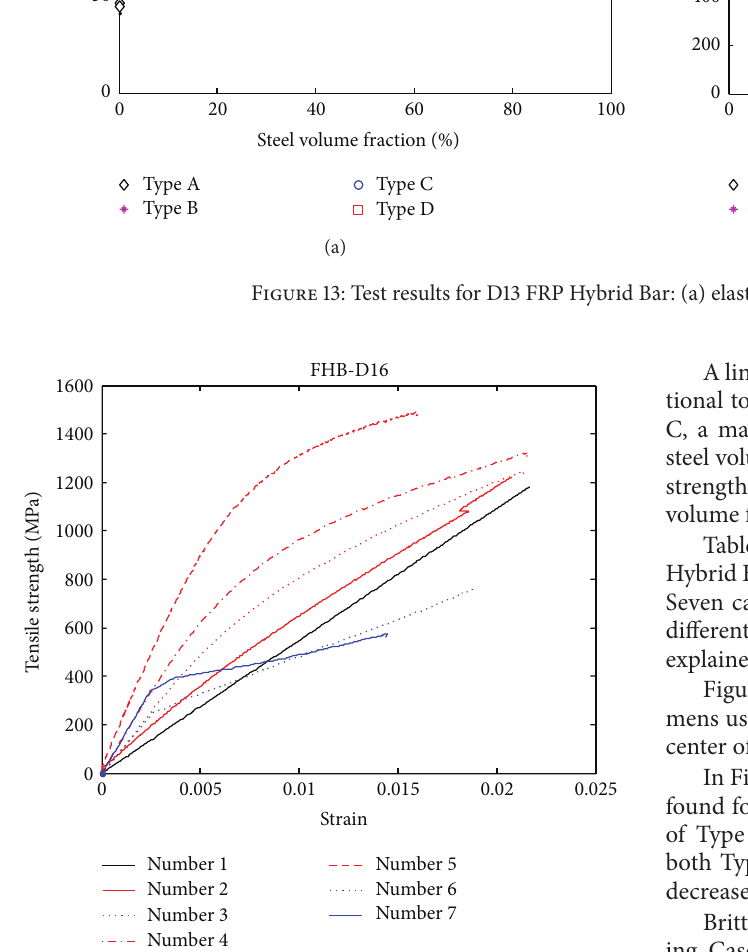
Figure 14: Stress-strain curves of D16 FRP Hybrid